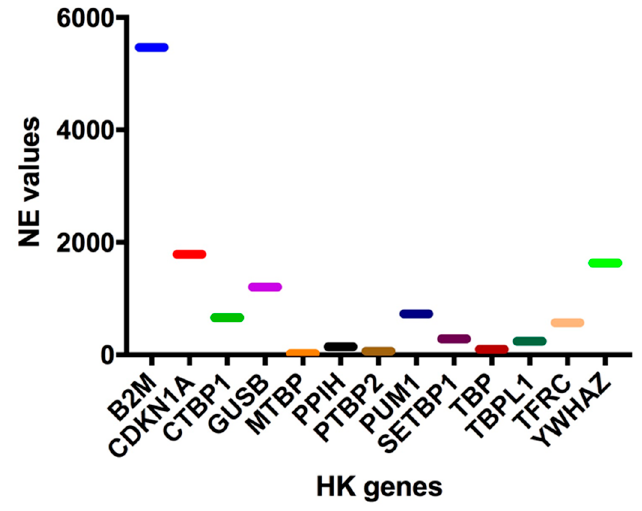
Figure 2. Housekeeping Genes (HK) normalized expression (NE) values. In order to normalize the 10-HH genes quantification values, expression data have been normalized using a housekeeping gene. Therefore, the normalized expression (NE) values of at least 13 known housekeeping genes (B2M, CDKN1A, CTBP1, GUSB, MTBP, PPIH, PTBP2, PUM1, SETBP1, TBP, TBPL1, TFRC, YWHAZ) were extrapolated from our 123-gene expression array data.